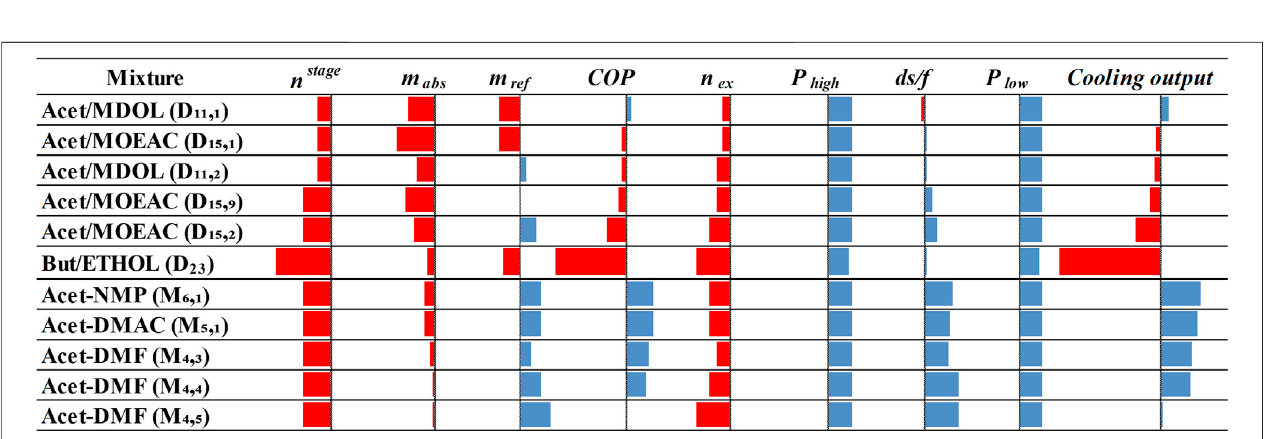
FIGURE 7 | Comparison of highest performing designed and literature mixtures with NH 3 /H 2 O in all indicators. Red bars pointing left indicate worse performance, whereas blue bars pointing right indicate better performance.